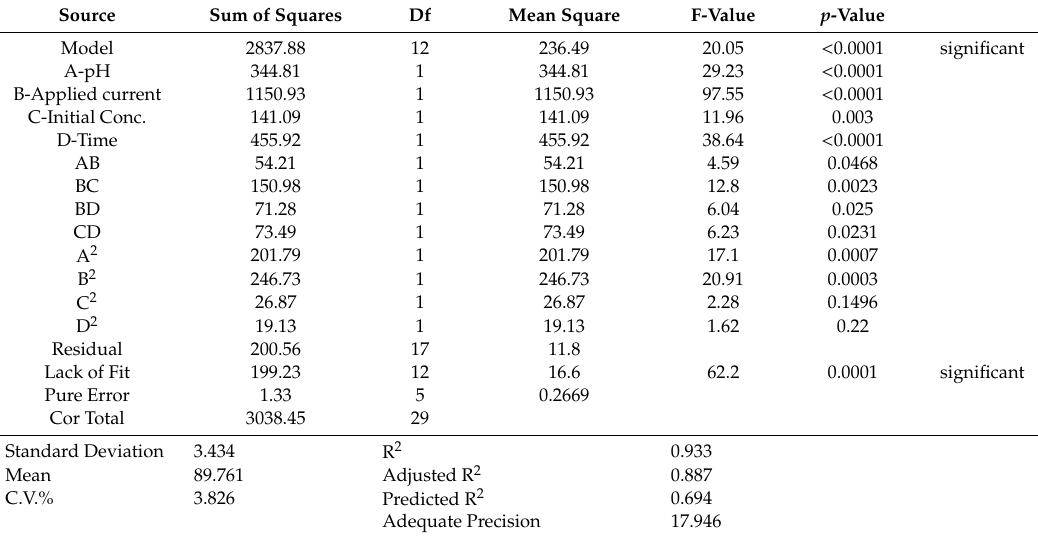
Table 2. ANOVA for total arsenic removal model.